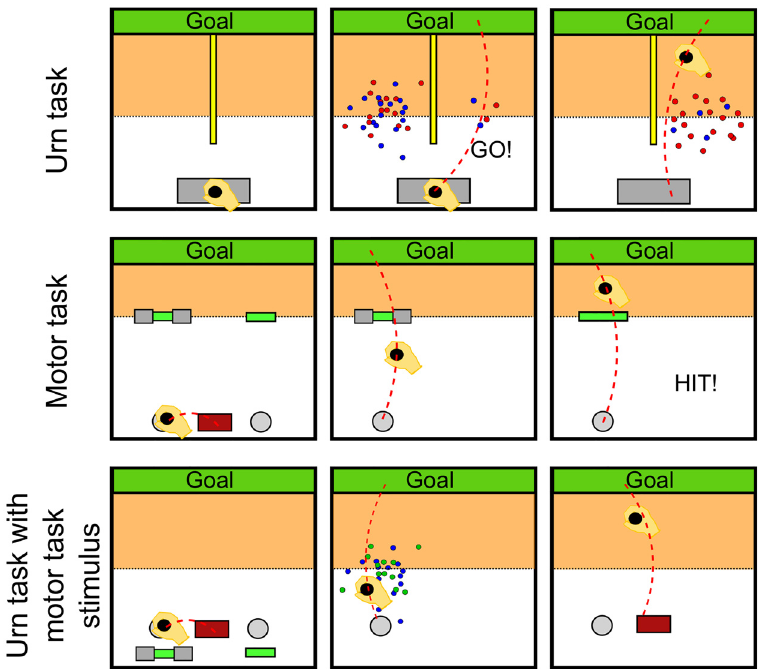
Fig 2. Experimental design. Top row . In the urn experiment, the trial was initiated by moving on a gray start bar. Two point clouds appeared showing samples from two urns with different underlying ratios of blue and red balls. The risky urn was always displayed by 100 samples drawn from a 50 : 50 ratio. The ambiguous urn had a variable number of samples drawn from an unknown ratio. Subjects made their decision about the urn they believed to have a higher red ratio by crossing into the area highlighted in orange. In case of choosing the ambiguous urn, the composition of the urn was revealed. The payoff was given by a viscous force field, which was switched on with the probability determined by the chosen urn ’ s ratio for blue. Middle row . In the motor task, subjects had to decide to hit one of two targets by moving into the corresponding decision circle. In case they chose a (partially) occluded target, the target became fully visible after crossing into the highlighted area. When failing to hit the target, subjects had to move against a viscous force field. In both experiments subjects had to move towards the goal bar and back. The orange color is only for illustration and was not displayed during the experiment. Bottom row . Experiment 2. Subjects are presented with the same stimulus as in the motor task but perform an urn task where the random outcome is computer generated, in contrast to the motor task where the outcome is determined by the subjects behavior. After choosing between an ambiguous and a risky option a cloud of points appeared revealing the composition of the hidden urn that determined the payoff in the same way as in the urn task.